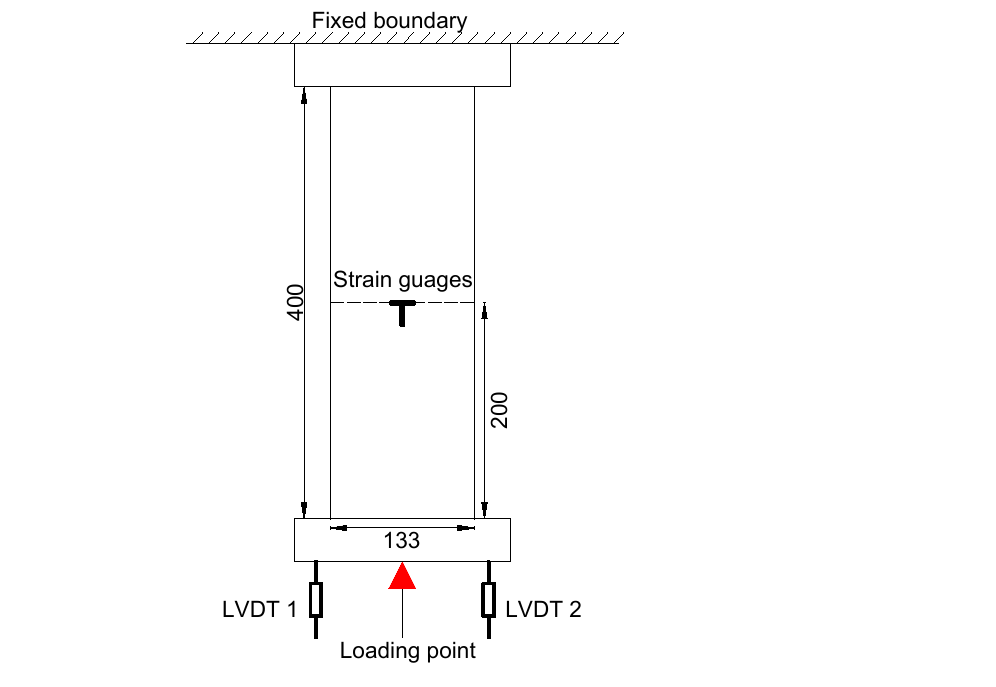
Figure 5. Measurement layout (front view).